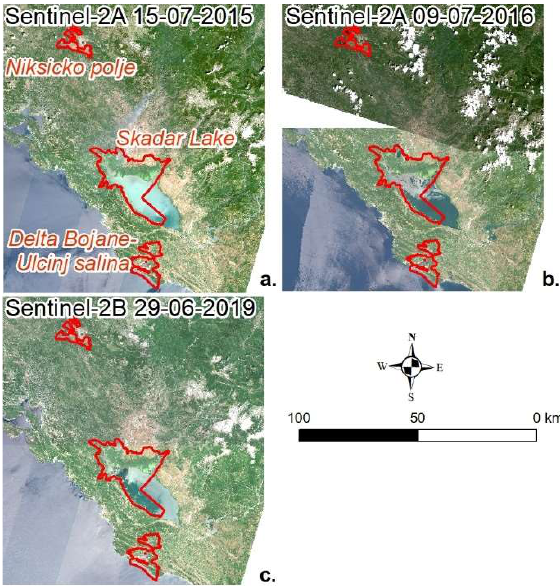
Figure 2. T34 TCM and TCN single-scene tiles processed over the three selected sites in summer 2015 (a), 2016 (b), and 2019 (c) for bi-temporal detection of deforestation.